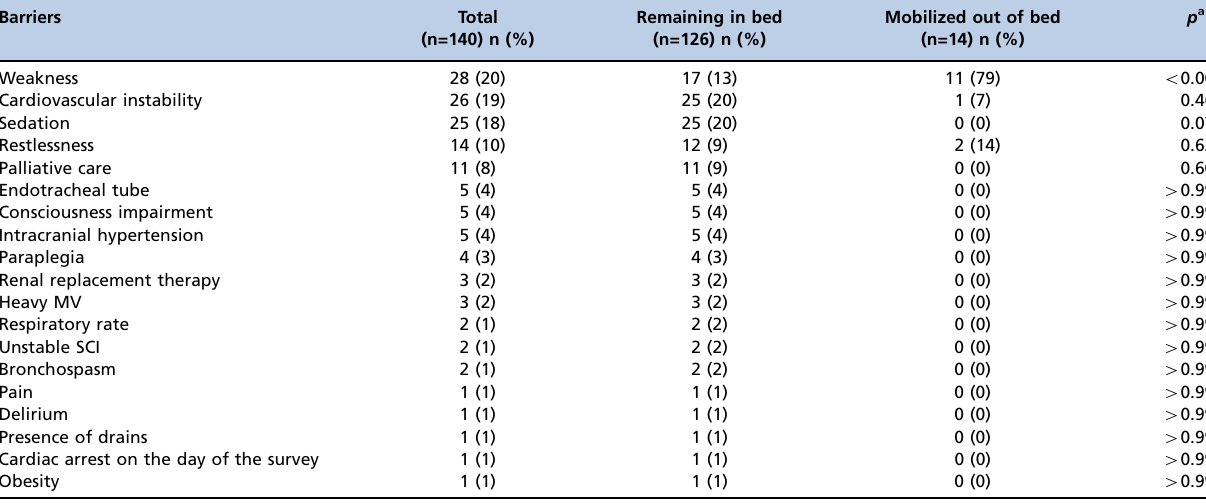
Table 5 - Perceived barriers to achieving a higher level of mobilization.